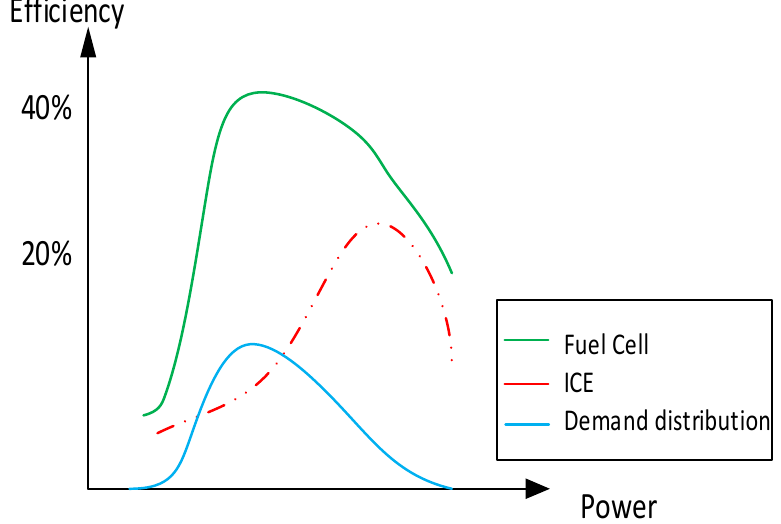
Figure 7. Fuel Cell & ICE Power Efficiency Curves [41].